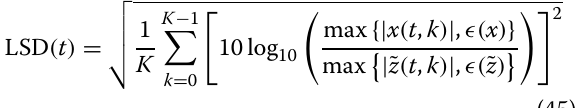
Table 1 The algorithm parameters Parameters Value Parameters Value 0.99